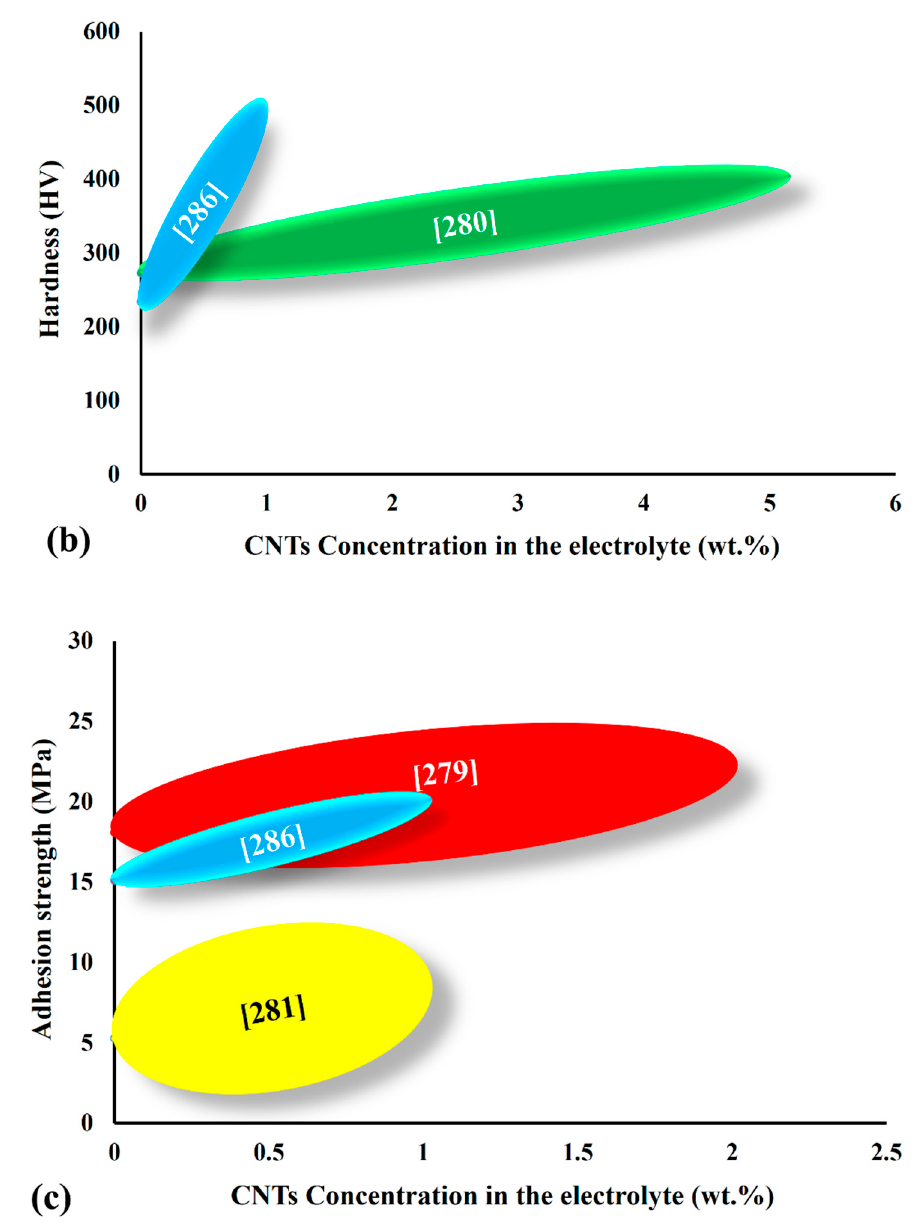
Figure 10. ( a ) The elastic modulus, ( b ) hardness, and ( c ) adhesion strength of the HAp-carbon nanotubes (CNTs) composite coatings as a function of CNTs loading in the electrolyte.